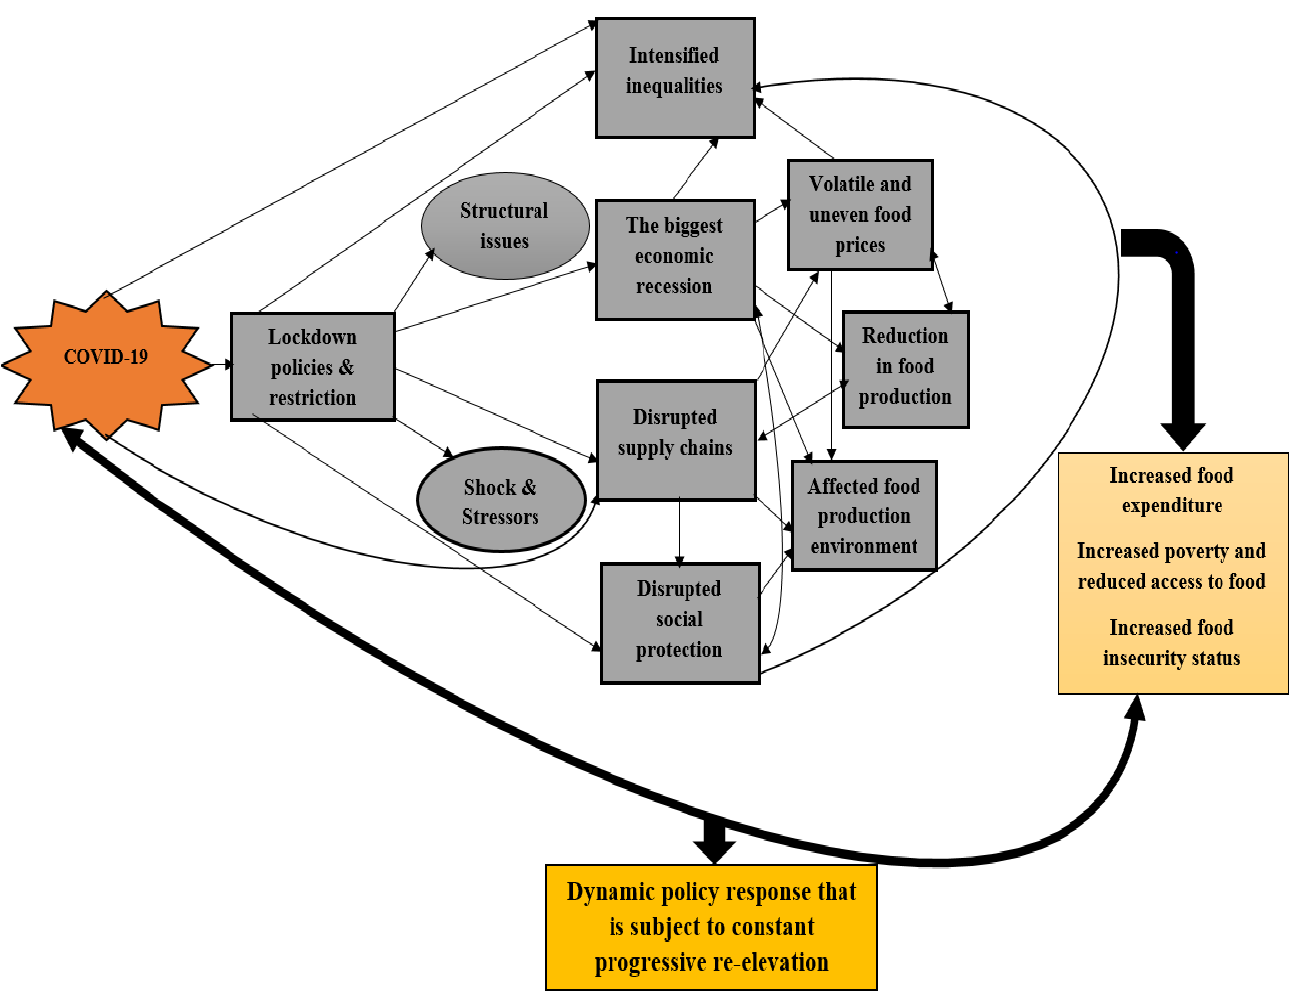
Figure 1. Dynamics of COVID ‐ 19 as it threatens food expenses and food security in Nigeria.